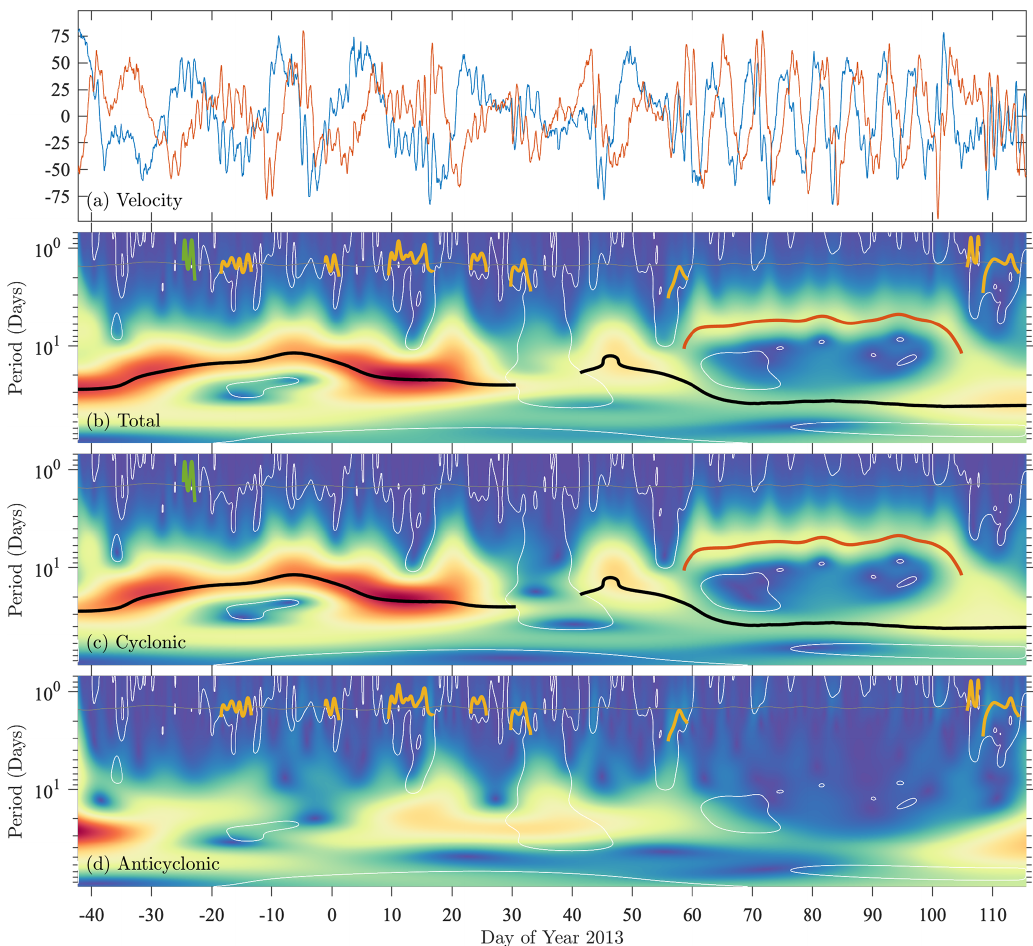
Figure 10. One-sided wavelet ridge analysis of the signal presented in Fig. 9a. In (a) , the zonal and meridional velocities v x (t) and v y (t) associated with the displacement signal from Fig. 9a are shown as blue and orange curves, respectively. Panel (b) shows the total wavelet (cid:112) | w + (t,s) | 2 +| w − (t,s) | 2 , while (c) and (d) show the magnitudes of the positive (or cyclonic) and transform magnitude, (cid:107) w (t,s) (cid:107) = negative (or anticyclonic) rotary transforms, | w + (t,s) | and | w − (t,s) | . The y axis in panels (b) – (d) is scale converted to oscillation period, 2 πs/ω β,γ . The thin, nearly horizontal gray line in panels (b) – (d) marks the time-varying Coriolis period 2 π/f (t) , while the thin white lines are curves where the magnitudes of the two rotary transforms are equal, | w + (t,s) | = | w − (t,s) | . The colored lines show all detected ridges (cid:107) w (t,s) (cid:107) using the same color scheme as in Fig. 9b. There are two sets of ridges: those detected in (cid:107) w (t,s) (cid:107) when the positive rotary (cid:98) s(t) of transform w + (t,s) dominates and those detected in (cid:107) w (t,s) (cid:107) when the negative rotary transform w + (t,s) dominates. To show their different origins, the ridges are superposed on the dominant transform as well as being drawn on the total transform (cid:107) w (t,s) (cid:107) . A condition of the one-sided algorithm is that the ridges terminate when they encounter the thin white lines, prohibiting transitions in rotation